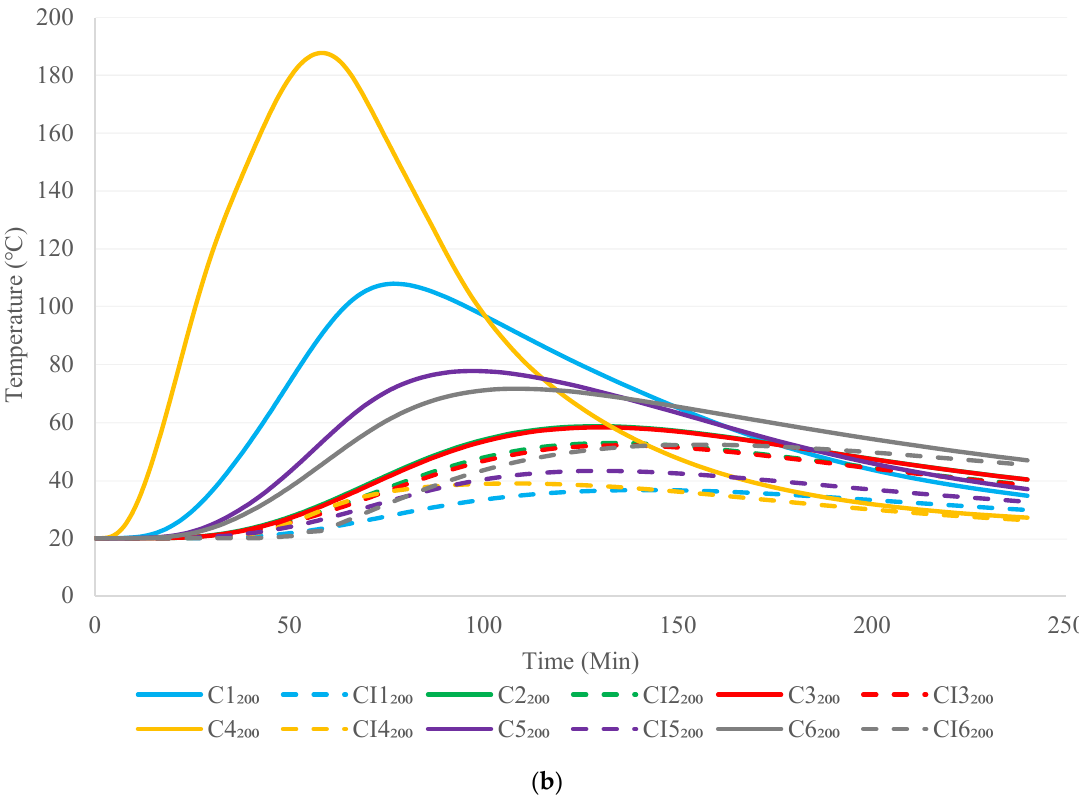
Figure 11. ( a ) Unexposed surface temperature variation of 100 mm wall configurations subjected to rapid fire. ( b ) Unexposed surface temperature variation of 200 mm wall configurations subjected to rapid fire.